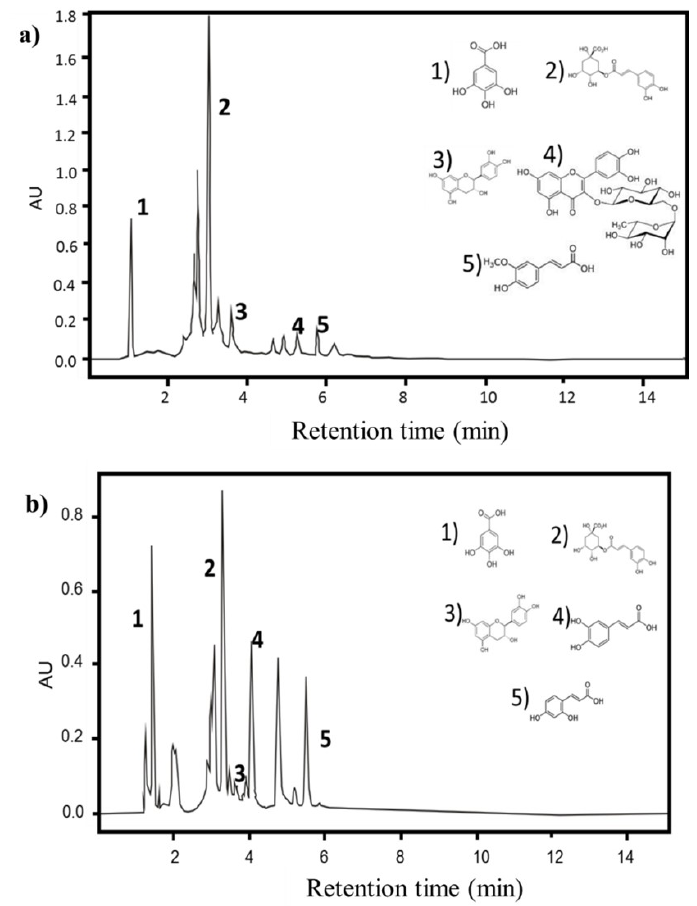
Figure 1. Identification of phenolic compounds of ( a ) the aqueous extract: 1. Gallic acid; 2. Chloro- genic acid; 3. Catechin; 4. Rutin and 5. Ferulic acid; and ( b ) ethanolic extract: 1. Gallic acid; 2. Chlorogenic acid, 3. Catechin; 4. Caffeic acid and 5. p -Cumaric acid.